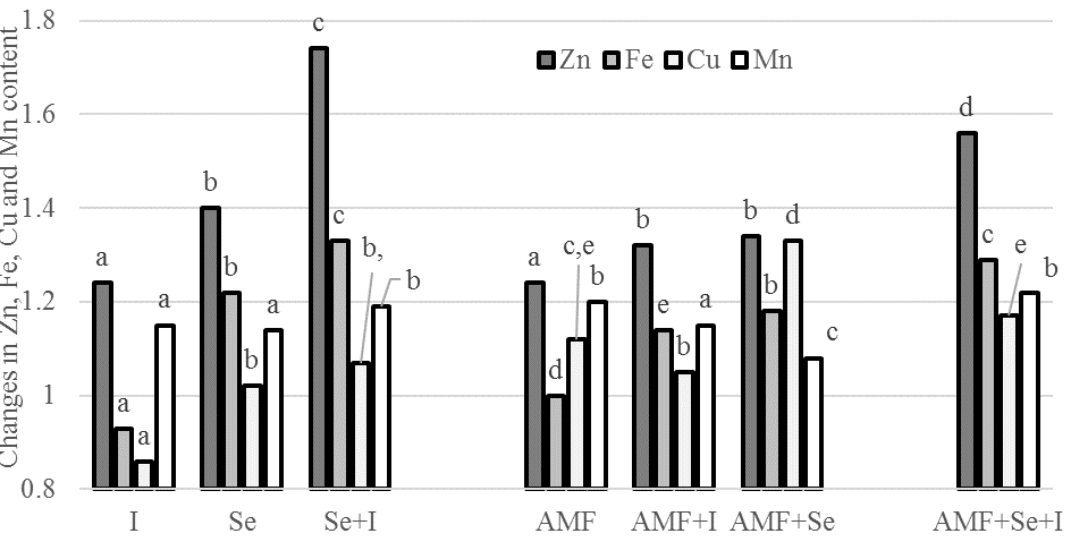
Figure 2. Effect of AMF, Se, and I application on microelement content in chickpea seeds. Values followed by different letters are significantly different according to Duncan’s test at p ≤ 0.05.